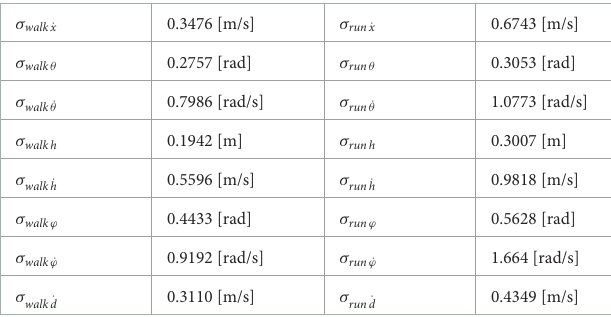
TABLE 3 Standard deviation of gaussian